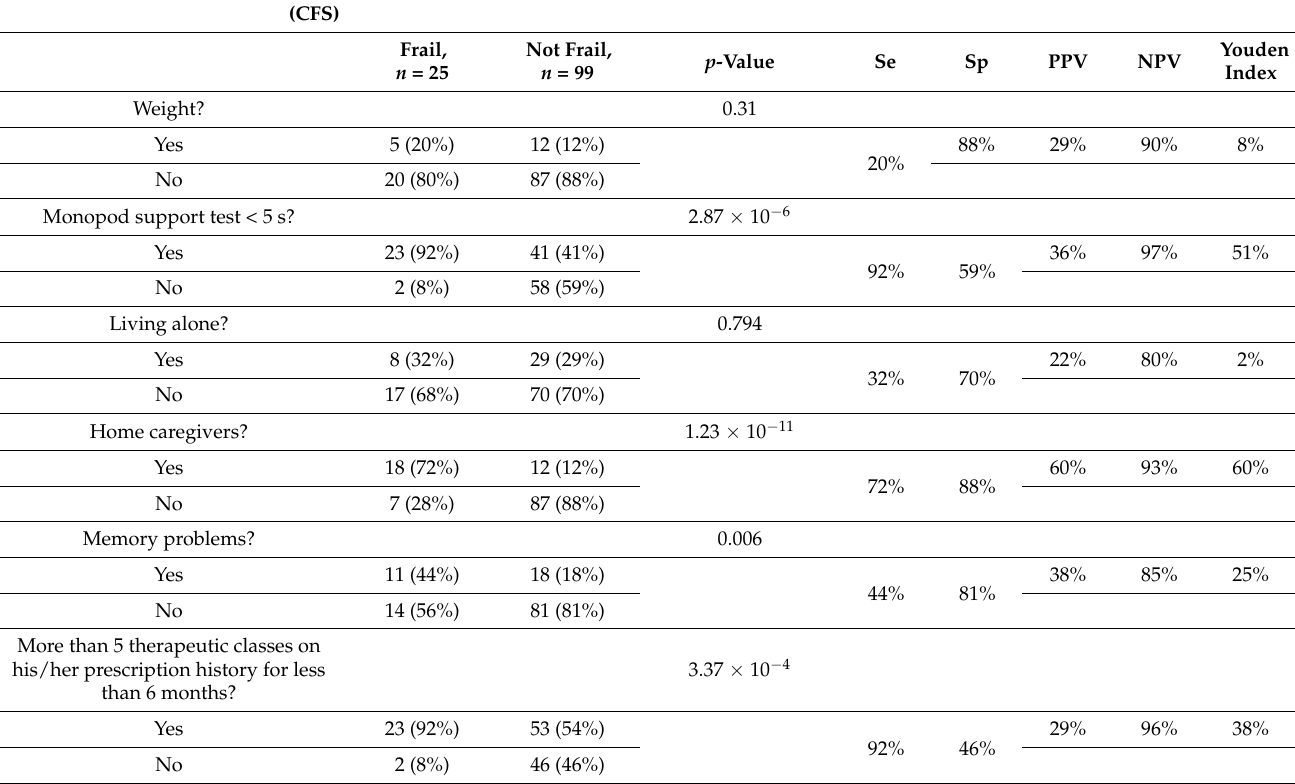
Table 5. Summary of all ZFS tool results compared to CFS.